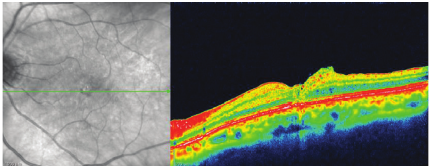
Figure 2: Spectral-domain optical coherence tomography (SD- OCT) image of a macular hole closed surgically with a lens